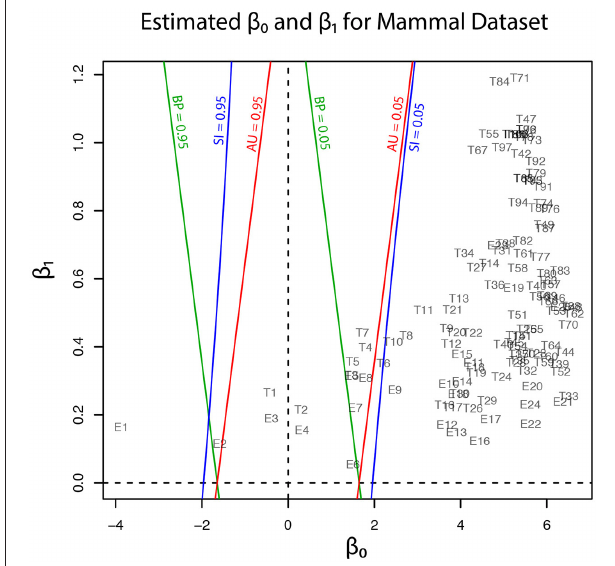
FIGURE 5 | Geometric quantities of regions ( β 0 and β 1 ) for trees and edges are estimated by the multiscale bootstrap method (section 3.4). The three types of p -value (BP, AU, SI) are computed from β 0 and β 1 , and their contour lines are drawn at p = 0.05 and